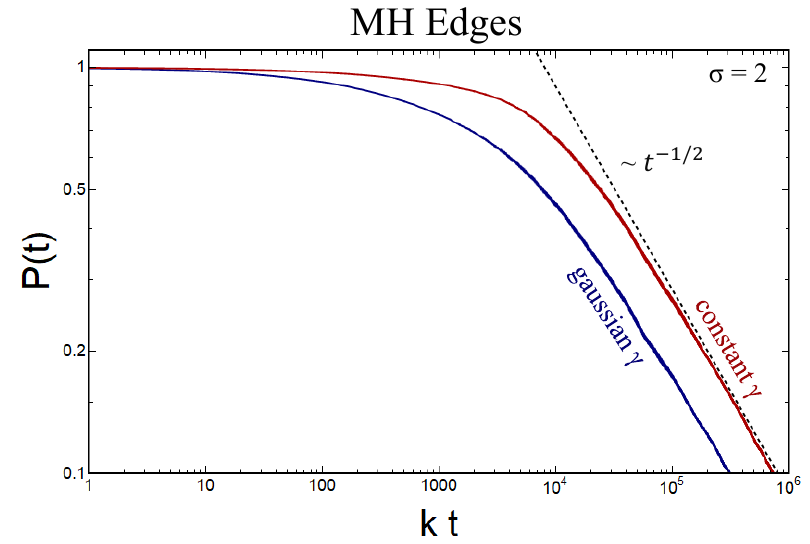
Figure 9. (Color online) Log-log plot of polarization decay for disorder constant σ = 2 in the MH- edges model for both versions of the local field magnitude. At long times, the decay is algebraic; the dependence agrees well with the trend ∼ t − 1/ σ (black dotted line). Additional parameters used in simulations are γ = 0.025 (for the Gaussian approximation, γ is the width of the distribution) and k =